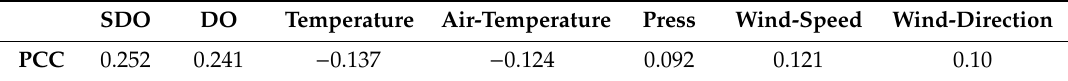
Table 5. PCC between model error and related factors.